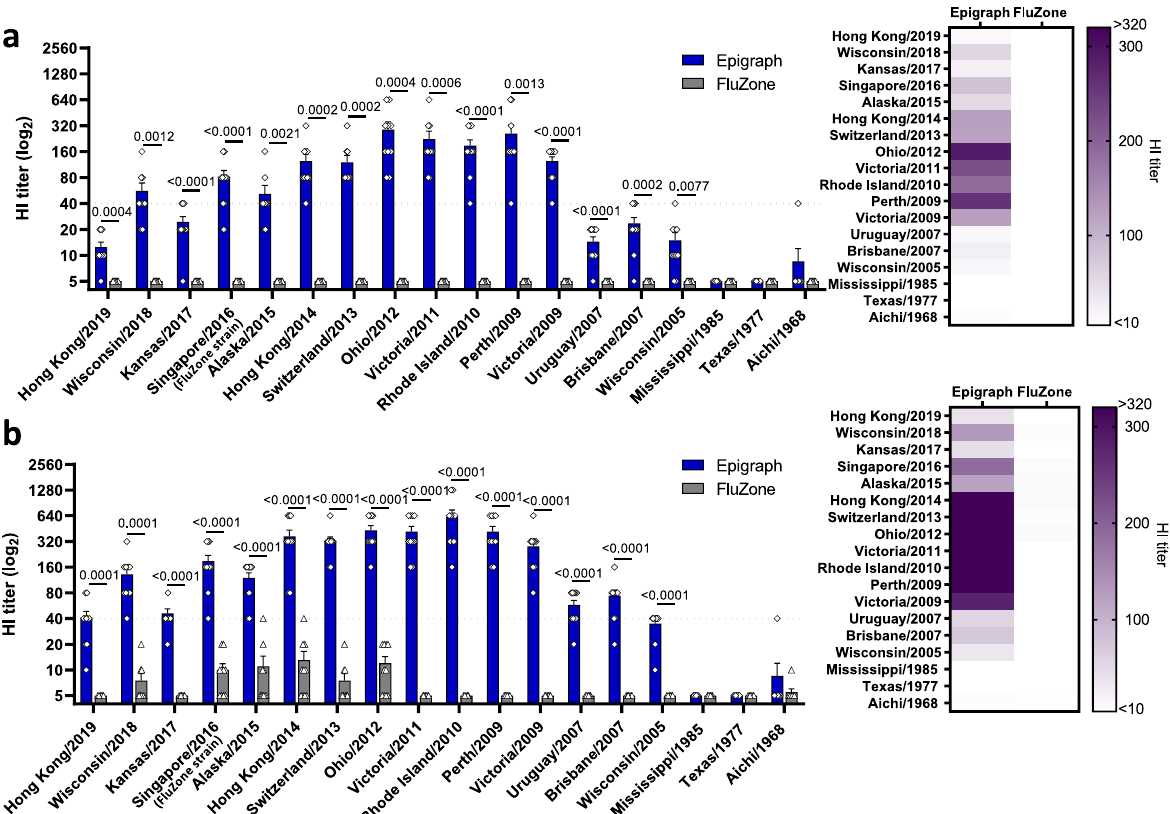
Fig. 7 Epigraph immunization induces cross-reactive antibody responses in ferrets against a panel of 18 representative H3 viruses. Ferrets ( n = 10) were immunized with 5 × 10 10 vp of the HAdV-5-Epigraph vaccine, a full human dose of FluZone, or a mock PBS vaccine. Antibody responses were measured using a HI assay against the 18 H3 representative strains for both a single immunization ( a ) or after boosting ( b ). A heat map of these HI titers was constructed to further visualize the total cross-reactive antibody response of each vaccine. Data are presented as the mean with standard error (SEM) ( n = 10; unpaired T